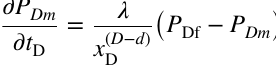
Fig. 4 The configuration of stimulated and unstimulated reservoir